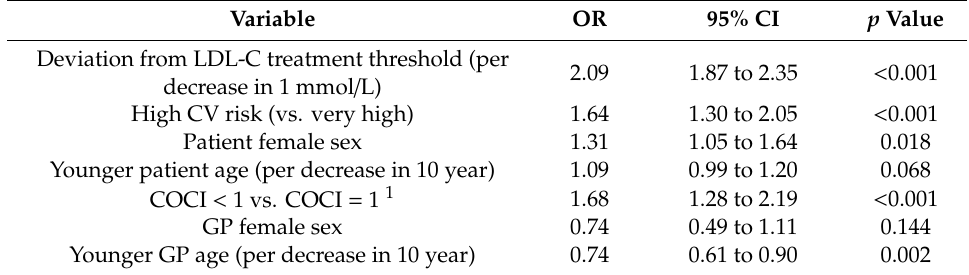
Table 2. Determinants of undertreatment. Patients for whom statin would be recommended were considered ( n = 3413); 5.7% ( n = 196) of these patients were ignored in the regression due to missing values. Variable OR 95% CI p Value Deviation from LDL-C treatment threshold (per 2.09 1.87 to 2.35 < 0.001 decrease in 1 mmol / L) High CV risk (vs. very high) 1.64 1.30 to 2.05 < 0.001 Patient female sex 1.31 1.05 to 1.64 0.018 Younger patient age (per decrease in 10 year) 1.09 0.99 to 1.20 0.068 COCI < 1 vs. COCI = 1 1 1.68 1.28 to 2.19 < 0.001 GP female sex 0.74 0.49 to 1.11 0.144 Younger GP age (per decrease in 10 year) 0.74 0.61 to 0.90